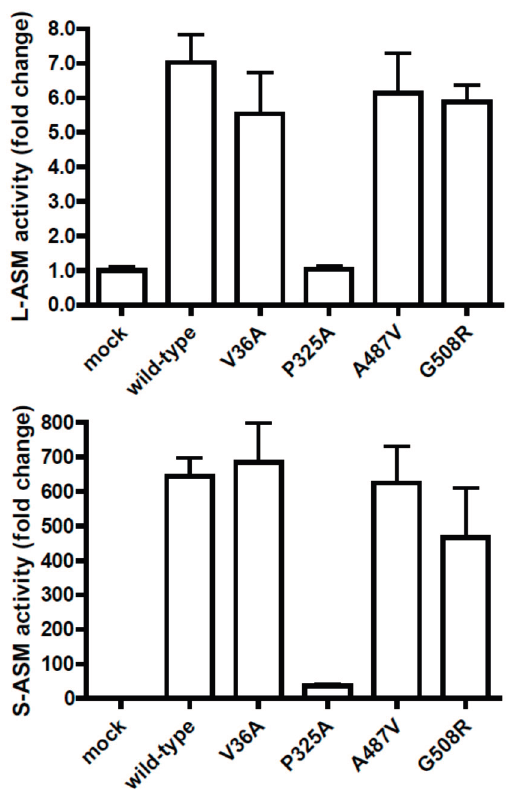
Figure 1. Analysis of sphingomyelin phosphodiesterase 1 ( SMPD1 ) sequence variations